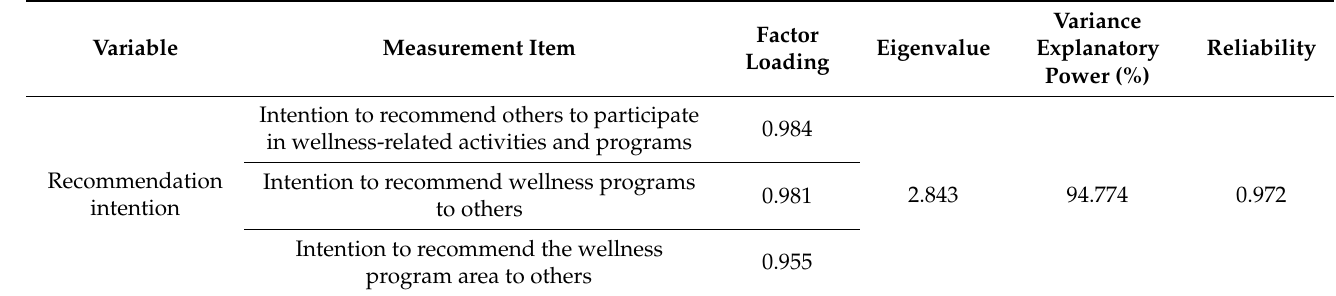
Table 9. Results of factor analysis of measurement items for intentions to recommend wellness tourism products.